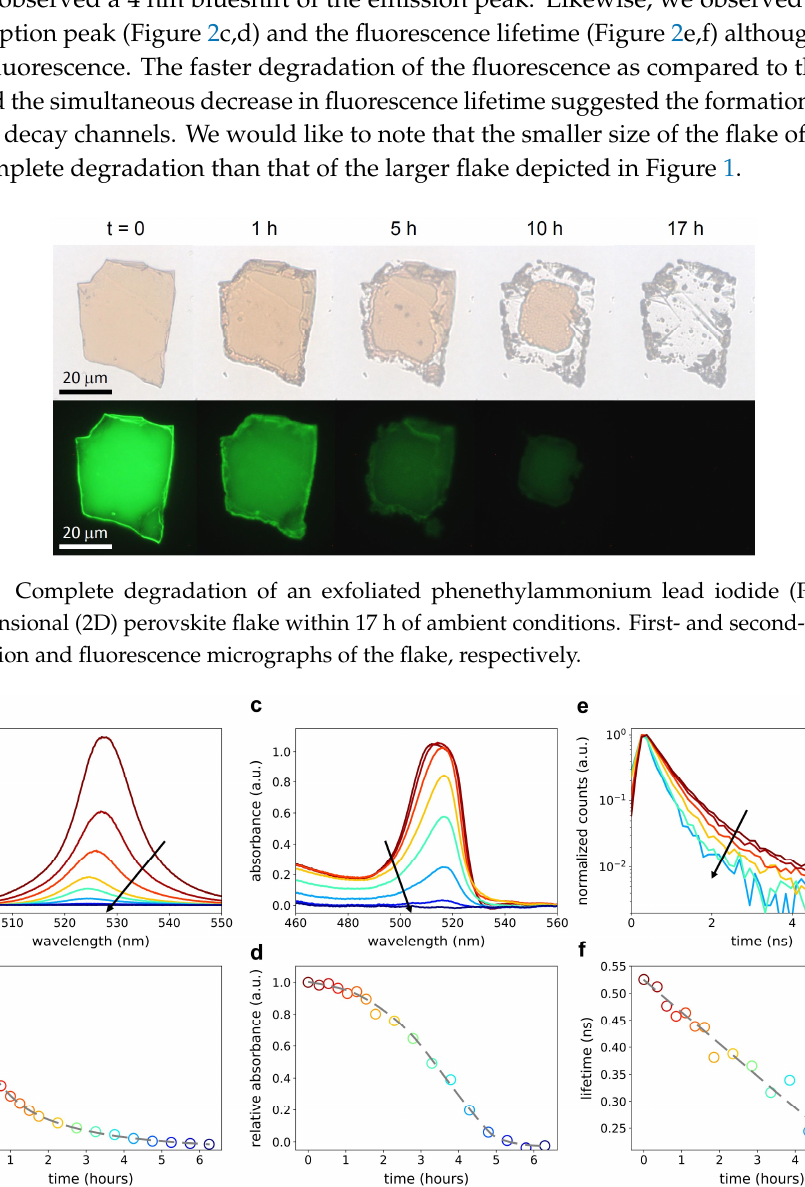
Figure 2. Spectral properties of a PEA 2 PbI 4 2D perovskite flake for di ff erent times under ambient exposure. ( a , c , e ) Fluorescence, absorbance, and fluorescence lifetime traces, respectively, for di ff erent times of ambient exposure. Traces shown correspond to times 0, 0.25, 1, 2.25, 3.25, 4.25, 5.25, and 6.25 h. Fluorescence lifetime traces are only shown for t < 5 h as the data was too noisy for later times. ( b ) Total fluorescence intensity from ( a ) normalized to the measured intensity at t = 0. ( d ) Integrated absorbance (455–594 nm) normalized to the measured absorbance at t = 0. ( f ) Extracted 1 / e lifetime from the fluorescence lifetime traces in ( e ). Gray lines in ( b ), ( d ), ( f ) are guides to the